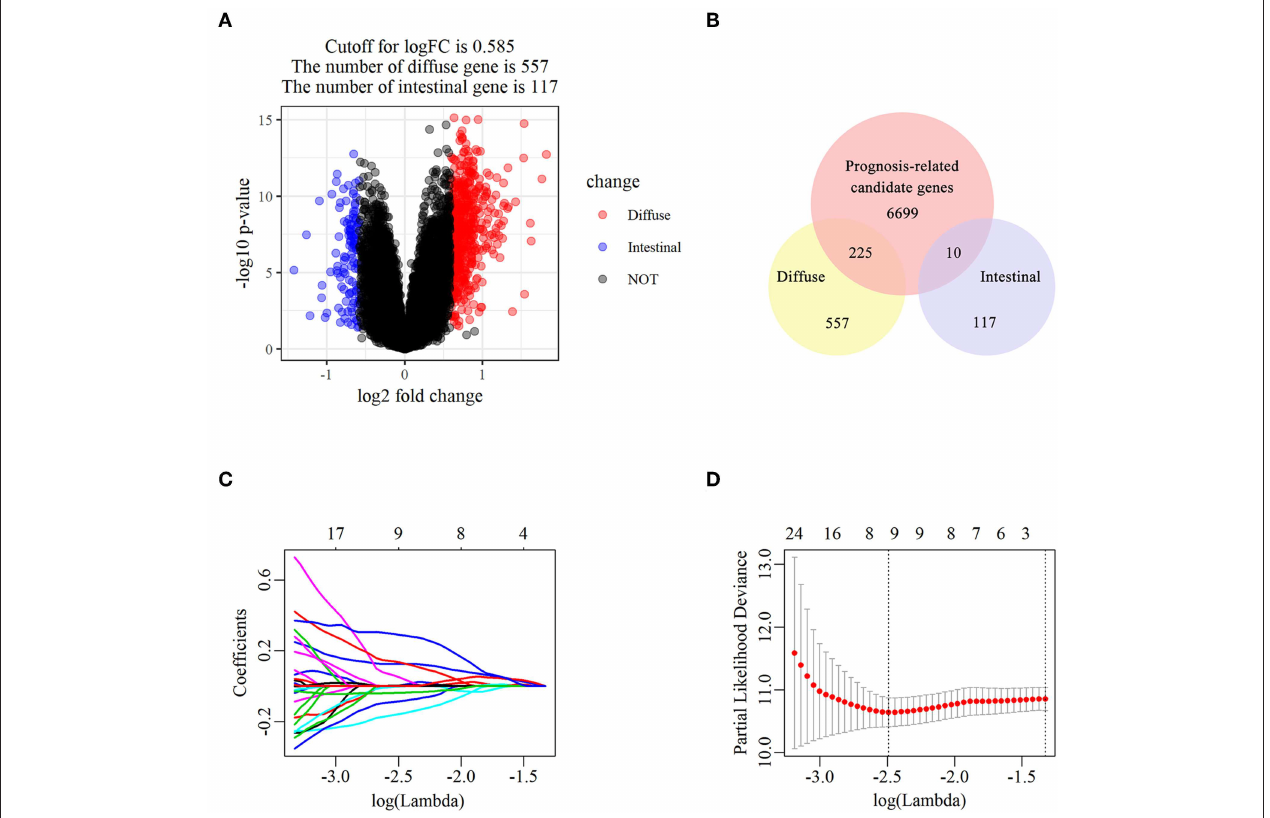
FIGURE 2 | The identification of diffuse type GC-specific multi-gene signature. DEGs between intestinal and diffuse type GC were showed in the volcano plot, in which the red plots represent the genes highly related with diffuse subtype whereas the blue ones represent the genes upregulated in intestinal subtype, while the cutoff for logFC was 0.585 (A) . The venn diagram showed that the candidate genes was screened through the intersection of prognosis-related genes with upregulated genes in intestinal and diffuse type GC, respectively (B) . The trajectory of each prognosis-related candidate gene’s coefficient in diffuse type GC was observed in the LASSO coefficient profiles with the changing of the lambda in LASSO algorithm (C) . After the 10-fold cross-validation, a confidence interval was got for partial likelihood deviance as the lambda changed. The dotted line indicated the best gene capacities (D)